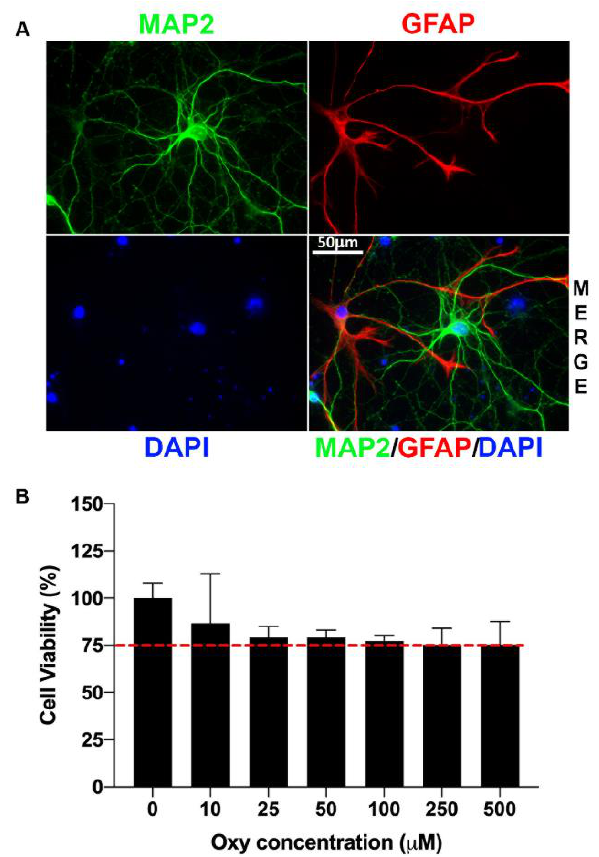
Figure 1. Mixed neuroglial culture purity and oxy dose selection. ( A ) Purity of mixed neuroglial cultures as evidenced by immunolabeling with MAP2 (neuronal marker) and GFAP (astrocyte marker). ( B ) Results of MTT assay for optimal selection of oxy concentration to be used in further in vitro studies. Oxy concentrations of 250 and 500 µ M resulted in >75% cell death; 100 µ M, which represented the highest concentration of oxy resulting in the least cell death, was used for our in vitro experiments. Data shown are from three independent